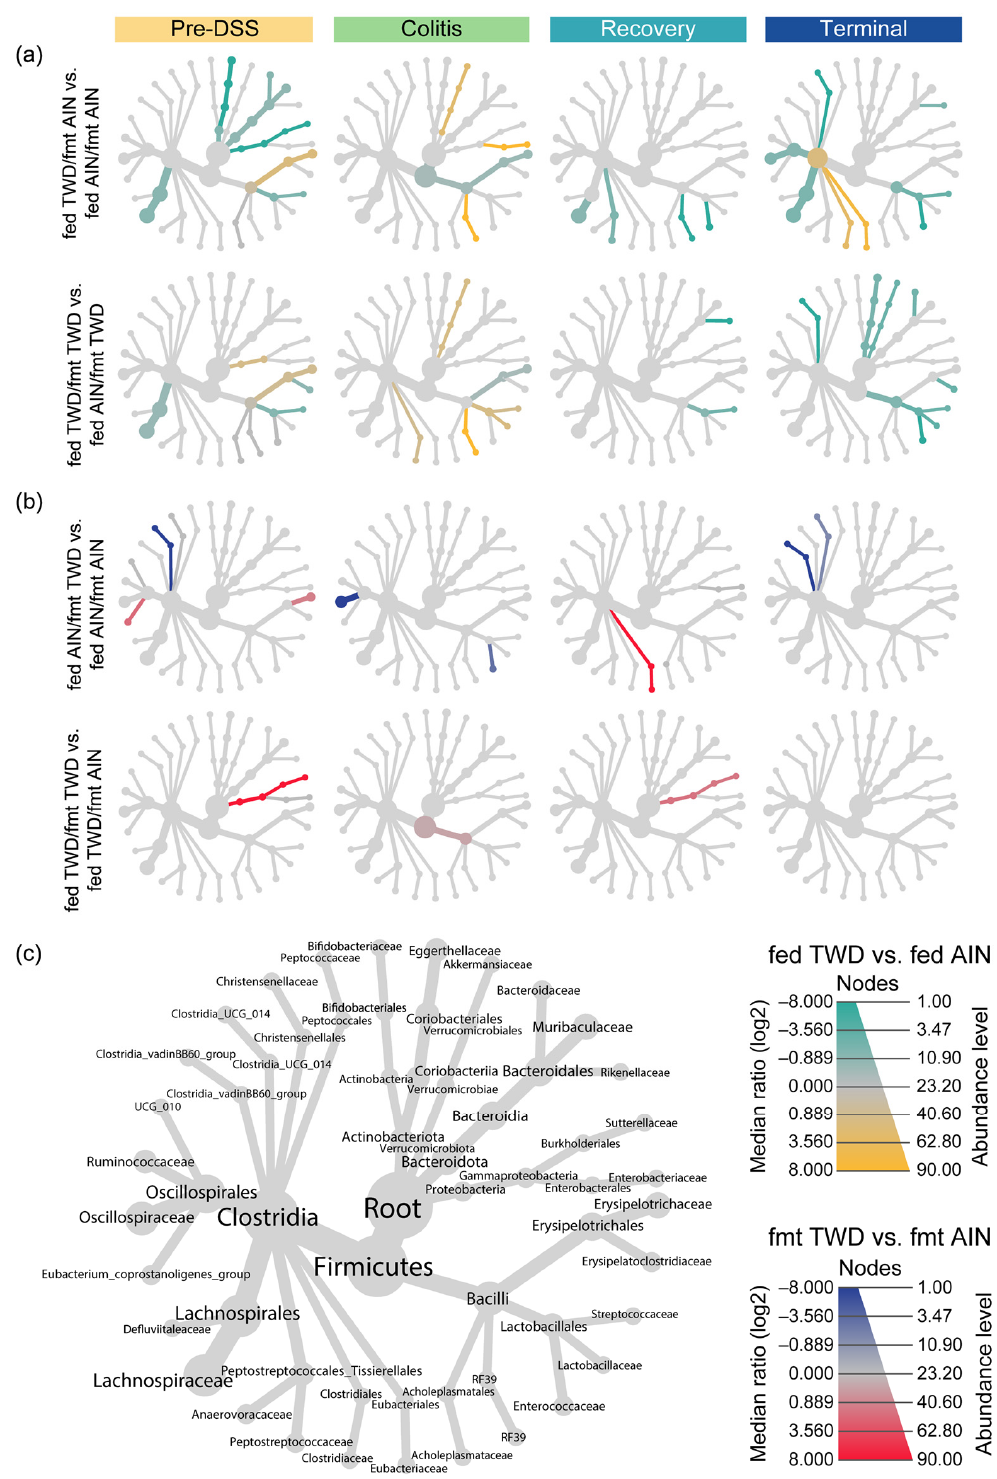
Figure 6. Fecal microbiome community structures depicted as heat trees, showing the relative abundance ratios for selected comparisons of recipient basal diet and FMT source at each experimental time point. ( a ) Comparisons of effects of recipient basal diet on mice receiving FMT from either an AIN-fed or a TWD-fed donor (green-to-yellow color bar, with yellow indicating greater abundance in the TWD-fed mice; top legend). ( b ) Comparisons for effects of FMT source on recipient mice fed either the AIN basal diet or the TWD (blue-to-red color bar, with red indicating greater abundance in FMT from the TWD-fed donors; bottom legend). ( c ) Phylogenetic structure of fecal microbiome bacterial community.